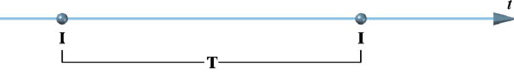
Figure 3: The two time elements and their notations.